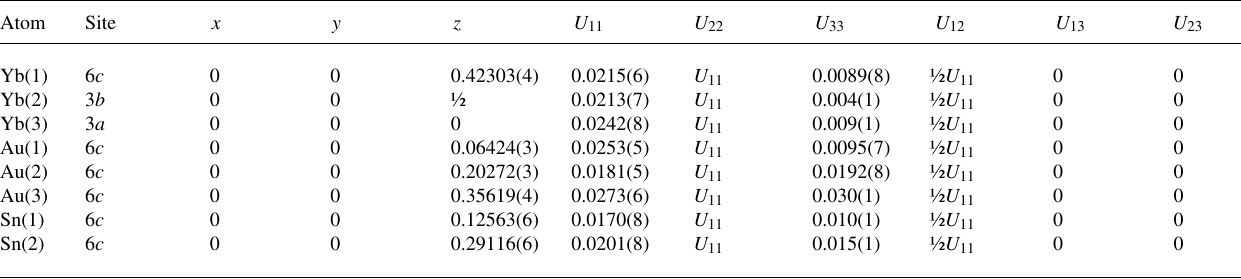
Table 2. Atomic coordinates and displacement parameters (in Å 2 )